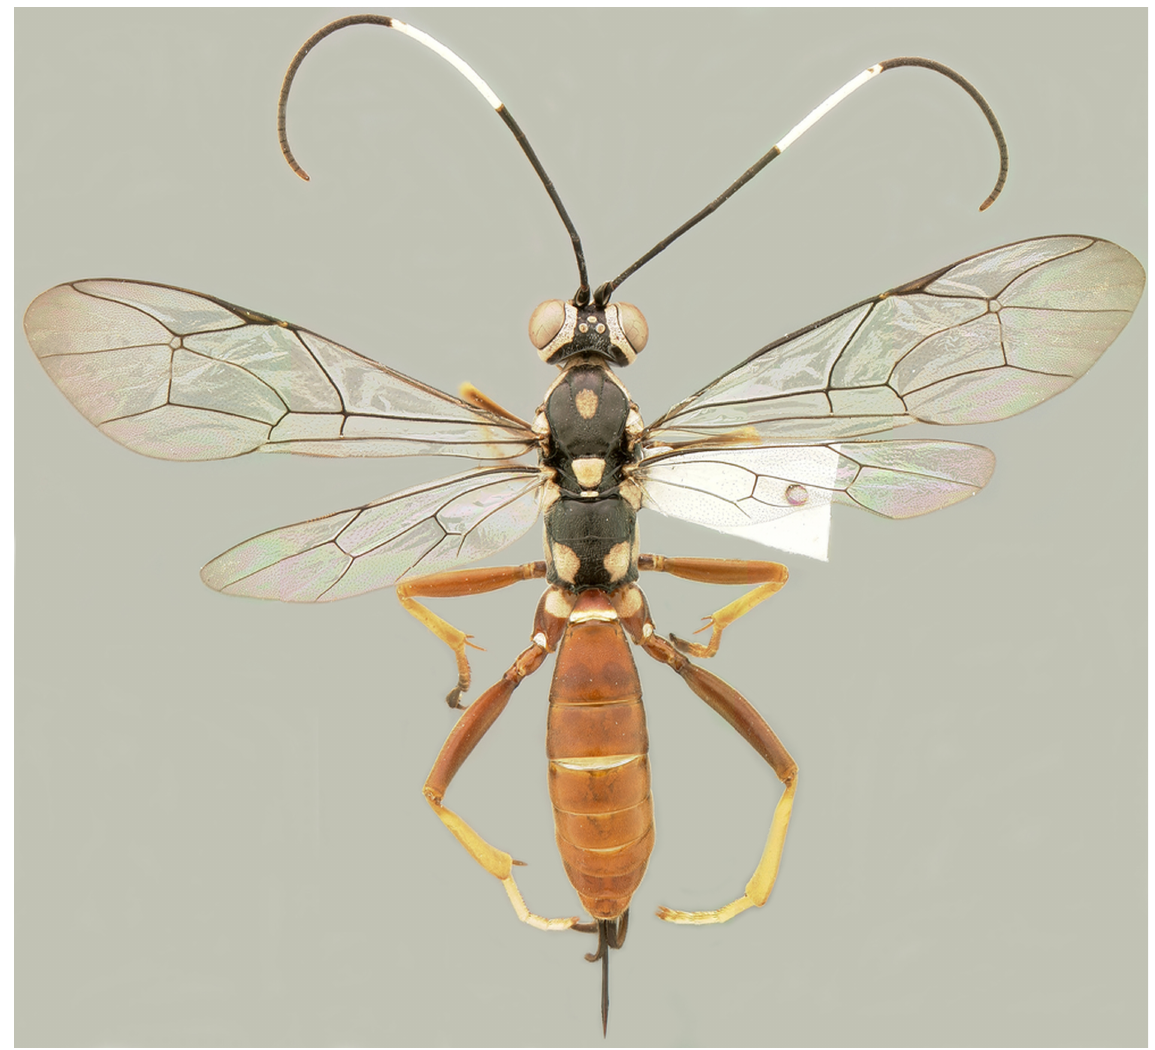
Fig. 3. Distictus paratibialis sp. nov., holotype (LAPIS5907), ♀, dorsal view. Photo by Berthil B.